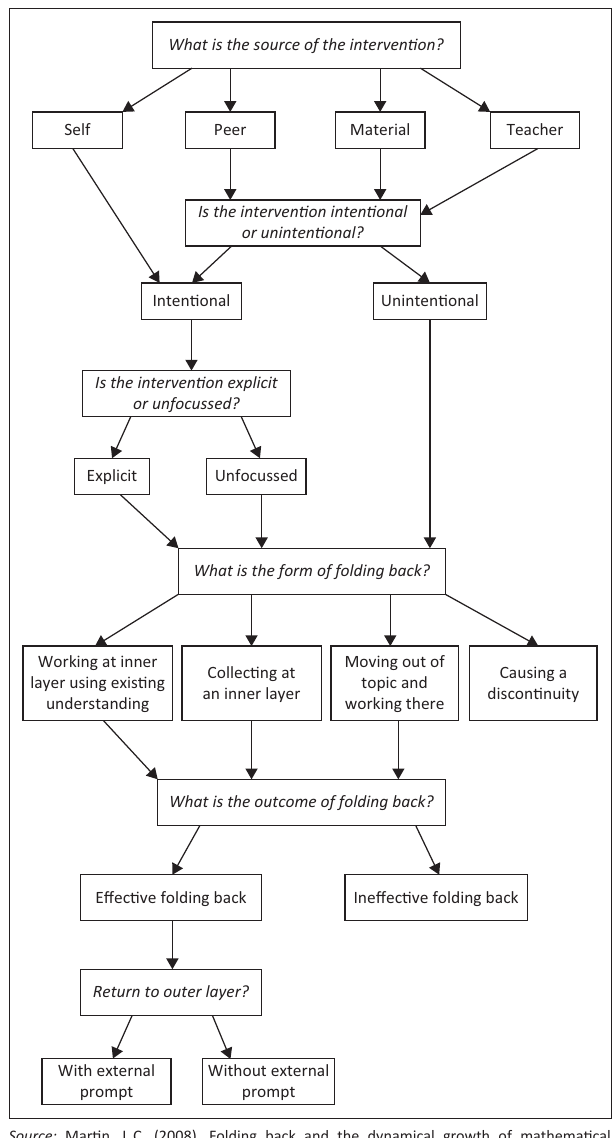
FIGURE 1: The framework for describing folding